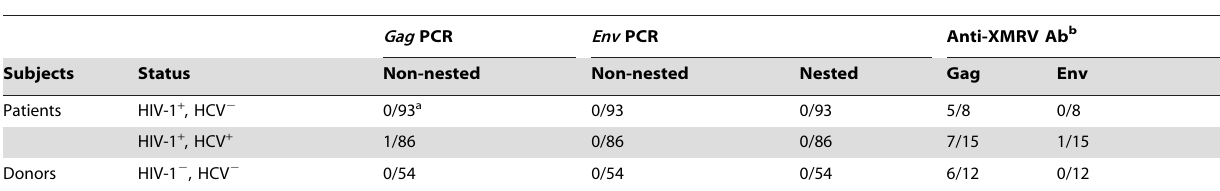
Table 2. Summary of XMRV screening